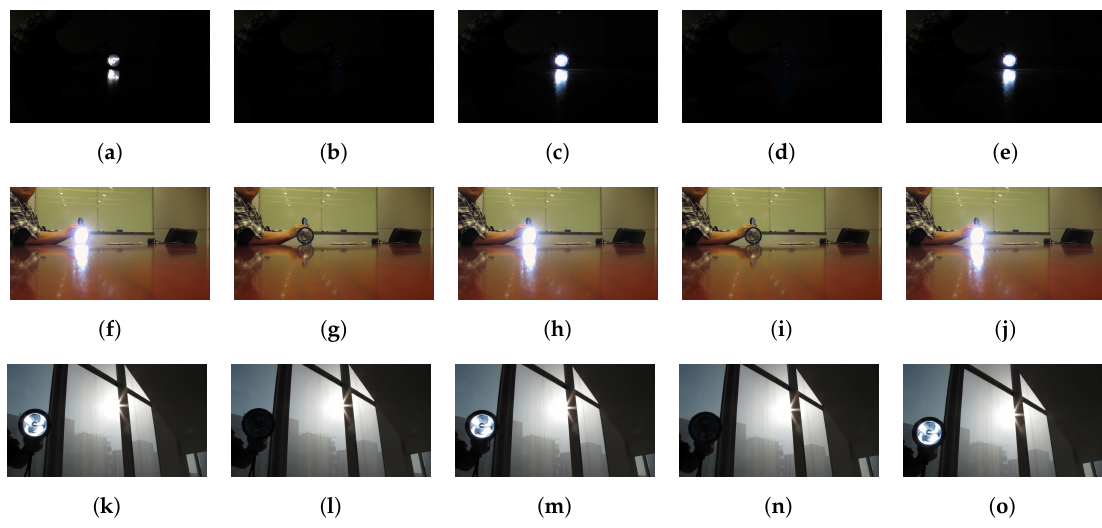
Figure 12. Continuous frames captured from different scenes for flash detection. The frames of the top row ( a – e ), the middle row ( f – j ) and the bottom row ( k – o ) are captured in the environments under weak, medium and strong illumination